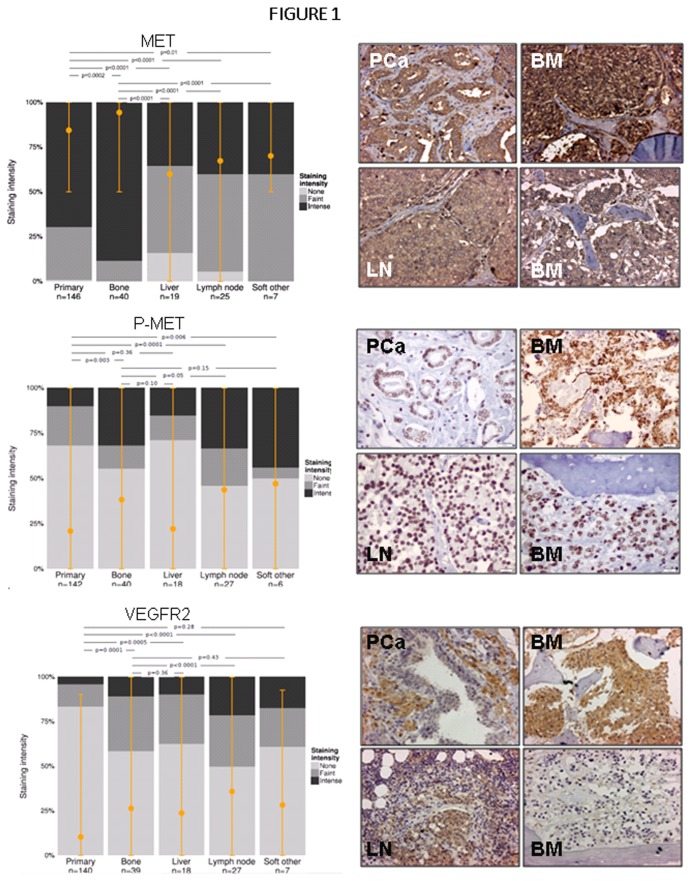
Expression of MET, P-MET, and VEGFR2 in primary and metastatic patient samples.IHC and analyses were performed as described in the Methods section. Graphical profiles illustrating distributions of staining intensity were constructed by calculating simple averages across all non-missing sections in each staining category. In each site, the mean staining index is marked by a filled orange circle and orange bars represent 95% CIs. Representative examples of staining are shown for each protein. A. MET is strongly expressed in both primary and metastatic PCa, though it is significantly increased in BM and decreased in soft tissue metastases vs. primary PCa. B. P-MET levels are higher in BM, LN and other soft tissue metastases, while no alteration was detected in liver metastases when compared to primary PCa. C. VEGFR2 expression is significantly increased across PCa metastatic lesions as compared to primary PCa. Images were taken at 400 x magnification.